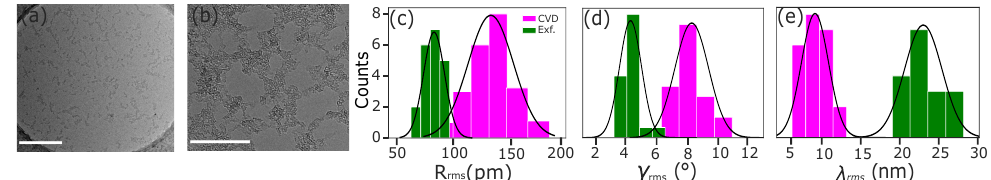
Figure 1. Corrugations in exfoliated and CVD-grown graphene. ( a , b ) Overview and high magni- fication TEM images of a CVD graphene sample. Scale bars are 300 nm and 30 nm, respectively. ( c – e ) Roughness/corrugation parameters; root-mean-square of corrugation height ( R rms ) , normal inclination ( γ rms ) , and the corrugation length ( λ rms ) for the exfoliated (green) and CVD (magenta) graphene samples. Black lines show the normal distributions corresponding to the mean and standard deviation of the data. The suspended area was 1.7 µ m in diameter for both CVD and exfoliated